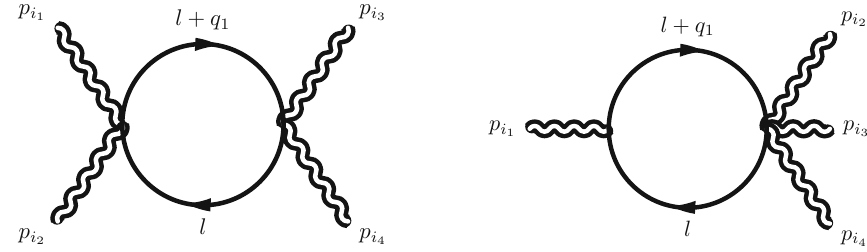
Fig. 5 The two kinds of bubble topology contributing to the < TTTT > correlation function in a scaleless theory. All the external momenta